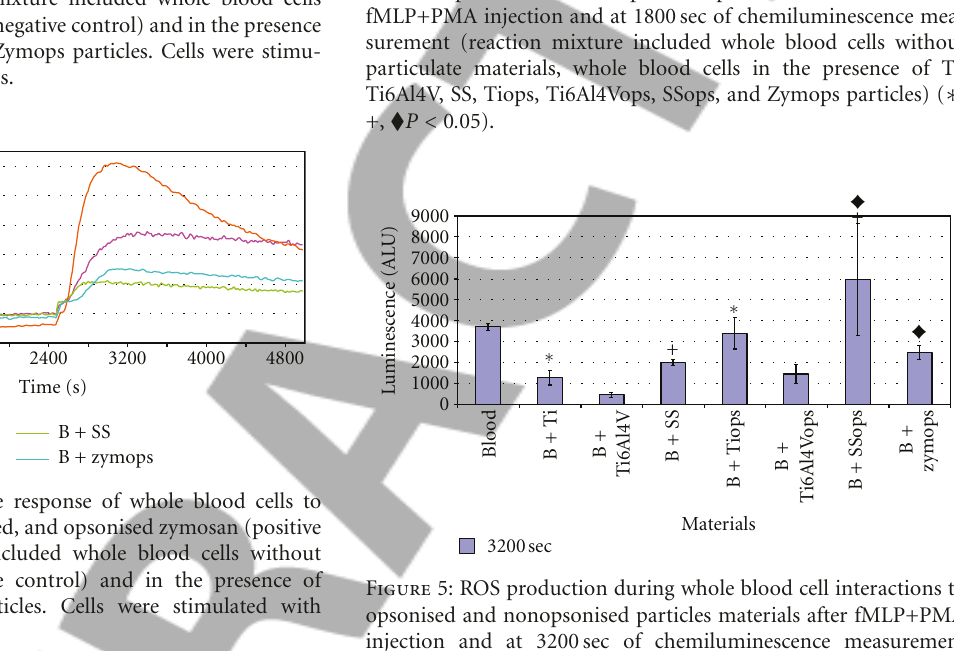
Figure 5: ROS production during whole blood cell interactions to opsonised and nonopsonised particles materials after fMLP+PMA injection and at 3200sec of chemiluminescence measurement (reaction mixture included whole blood cells without particulate materials, whole blood cells in the presence of Ti, Ti6Al4V, SS, Tiops, Ti6Al4Vops, SSops, and Zymops particles) ( ∗ , +, (cid:2) P < 0 .